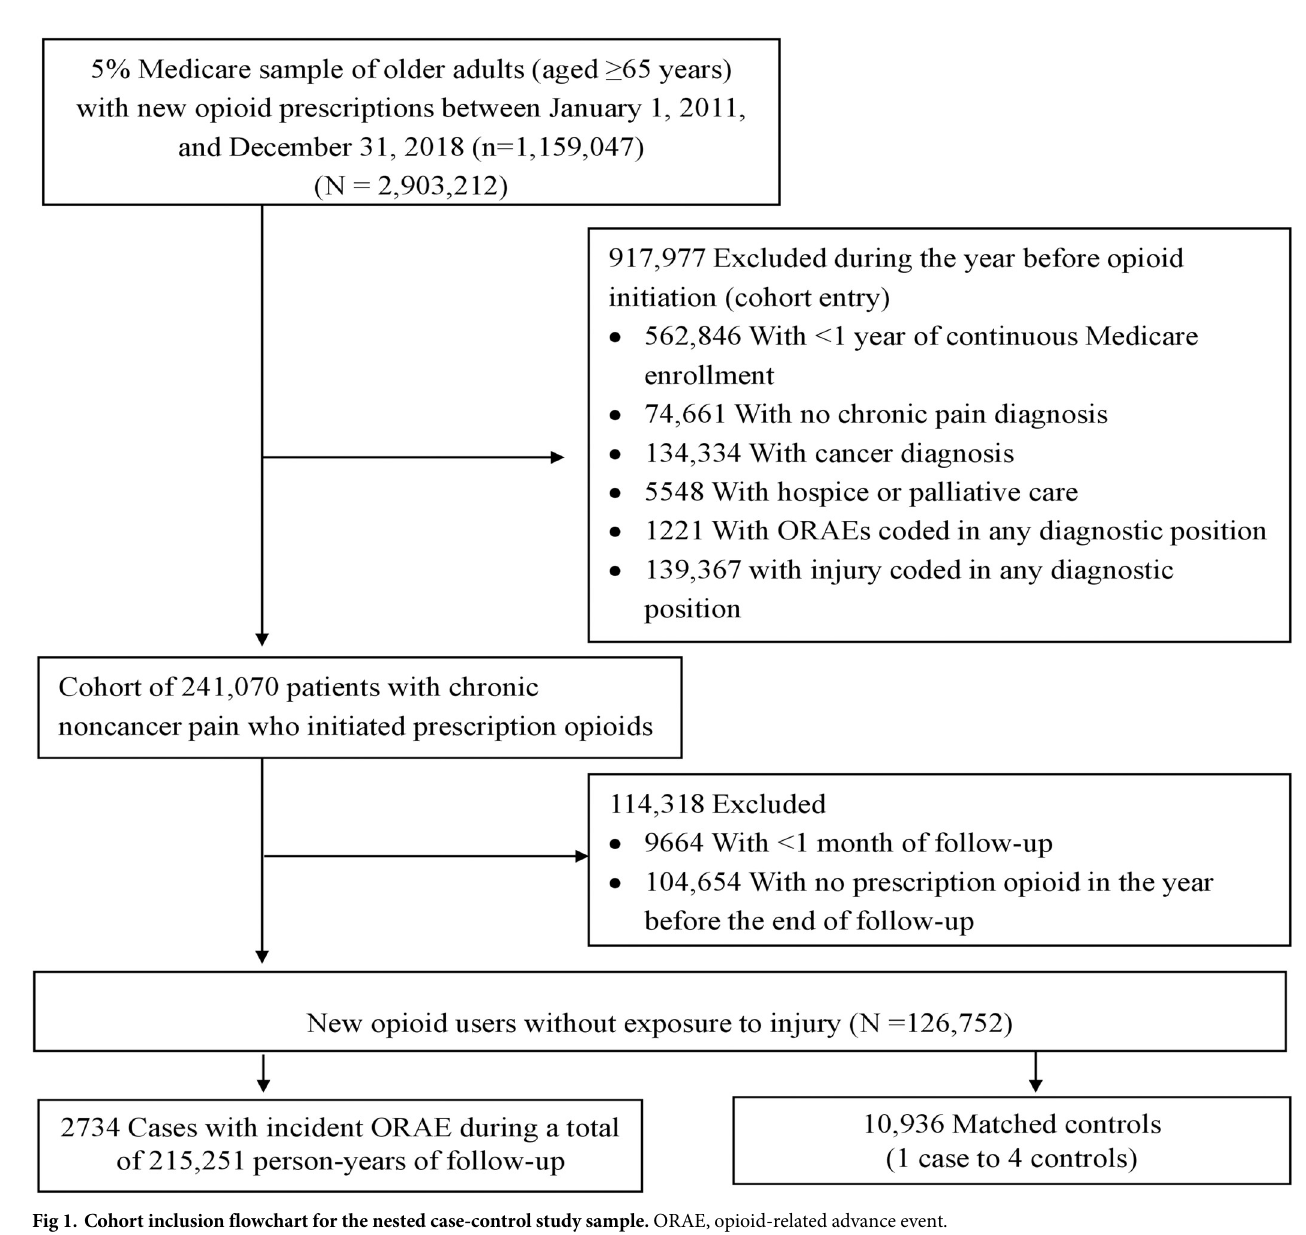
Fig 1. Cohort inclusion flowchart for the nested case-control study sample. ORAE, opioid-related advance event.